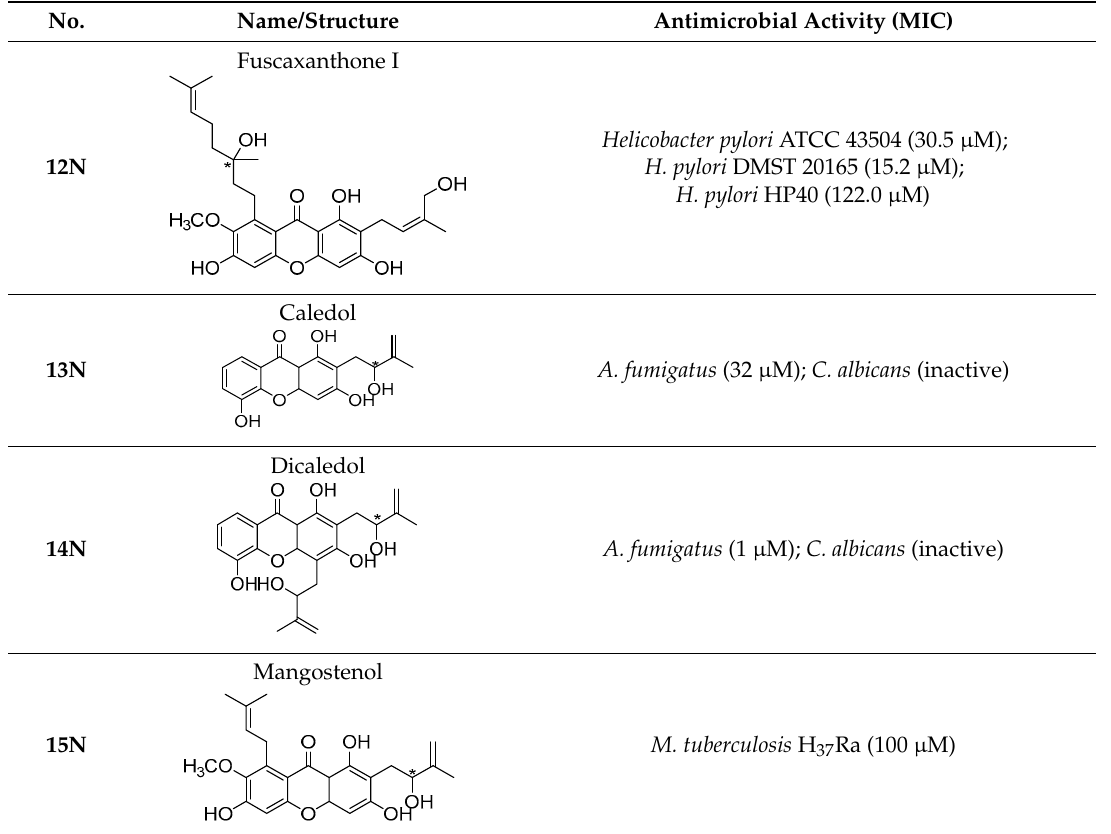
Table 3. Antimicrobial activity of natural CDXs with hydroxy side chains.